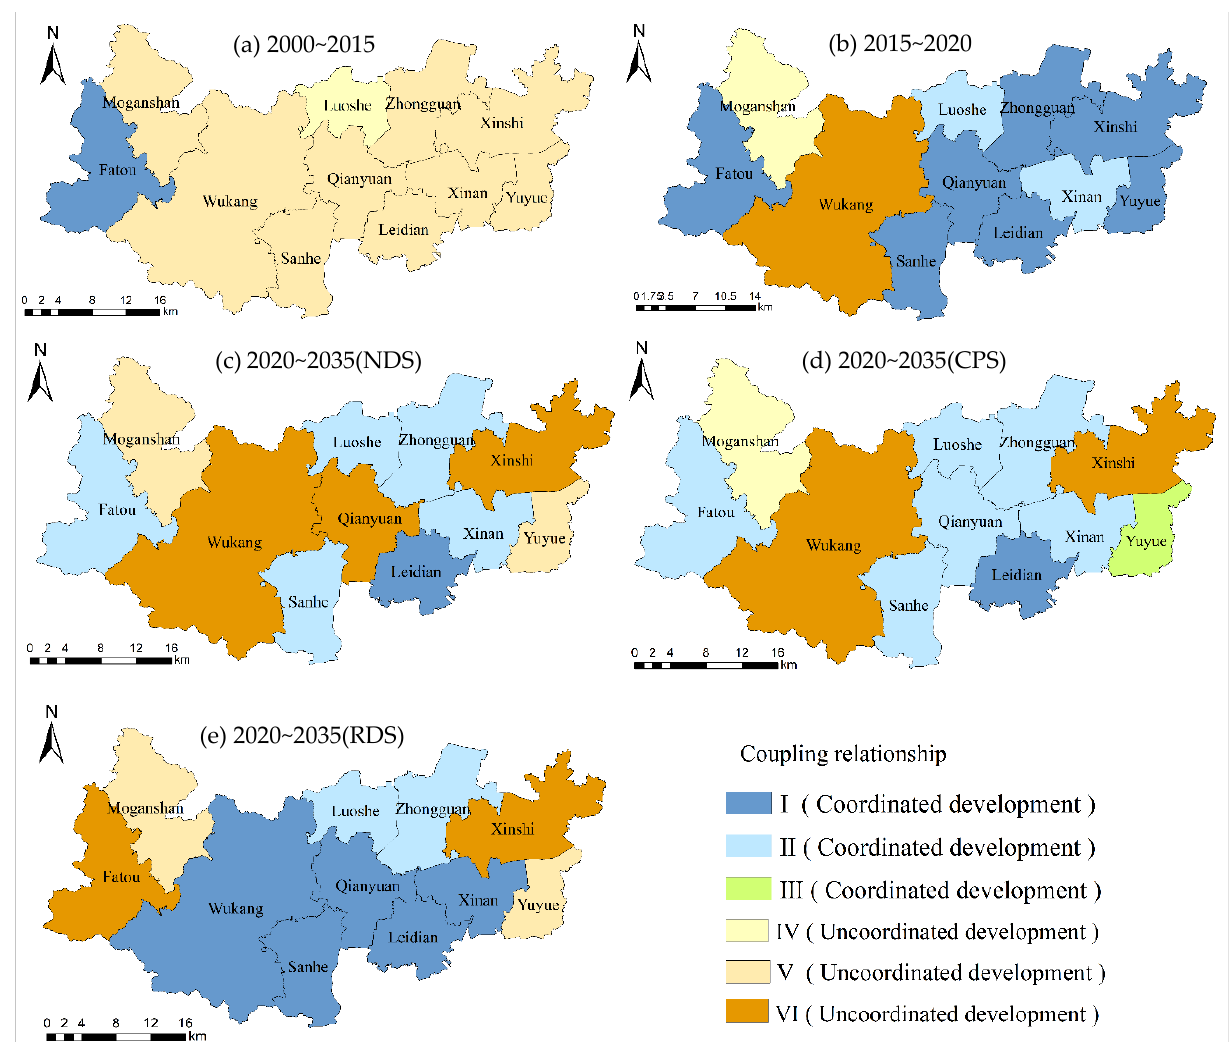
Figure 10. Spatial changes in coupling relationship between rural settlements and rural population from 2000 to 2035 (NDS, CPS, and RDS).